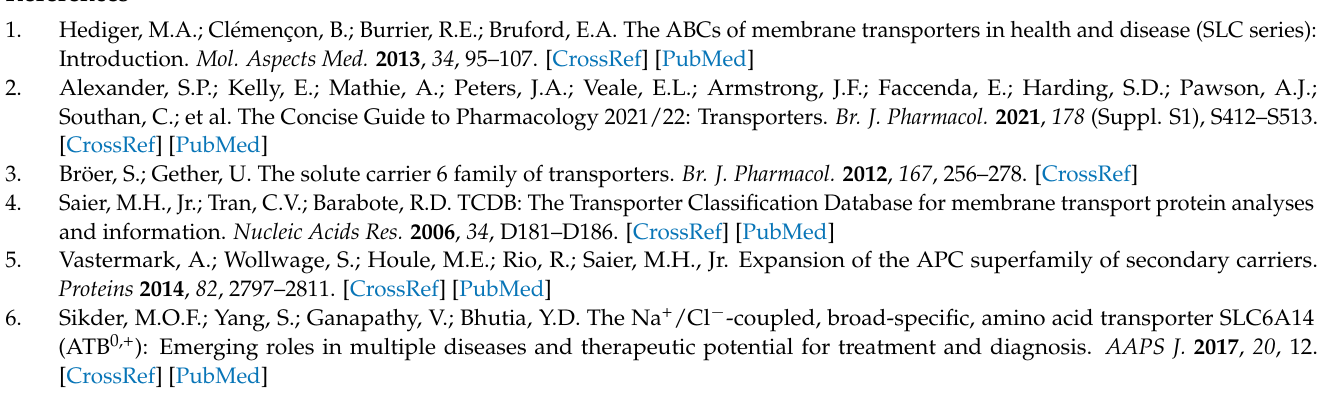
Figure S2: V128 occupies a key position, towards the bottom of the binding pocket, in SLC6A14 and in other SLC6 transporters; Figure S3: V128F in TM3 reduces transport of the dibasic amino acid arginine via SLC6A14 whereas V128I increases affinity for the small dipolar amino acid serine; Figure S4: The orientation of W376 in the SLC6A9 (GlyT1) transporter differs from that predicted for W327 in SLC6A14 and “blocks” the TM3 residue I192 from the binding pocket